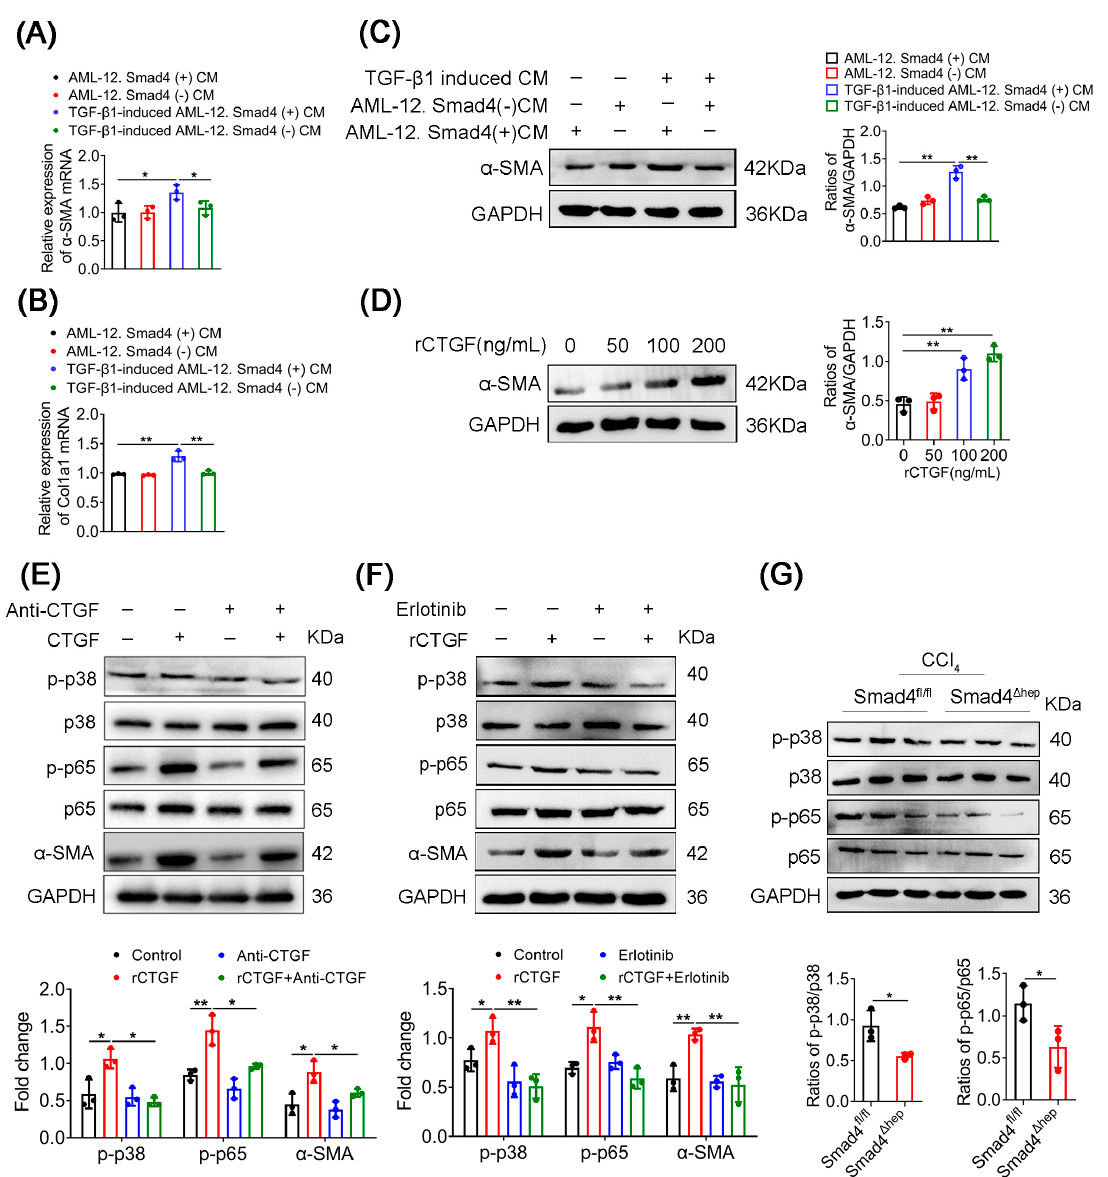
Figure 6. CTGF promotes HSCs activation via the EGFR receptor mediated p38/p65 signaling. AML-12 cells were transfected with control siRNA or Smad4 siRNA, respectively, and treated with TGF- β 1 (5 ng/mL) for 24 h. Subsequently, the conditioned medium was collected to treat LX-2 cells. ( A , B ) The mRNA levels of α -SMA and Col1a1 in LX-2 cells were measured using the real-time PCR method. ( C ) Western blotting analysis of α -SMA protein levels in LX-2 cells. α -SMA was normalized to GAPDH. ( D ) LX-2 cells were treated with recombinant CTGF protein (0 ng/mL, 50 ng/mL, 100 ng/mL, 200 ng/mL) for 48 h. Western blotting analysis of protein levels of α -SMA in LX-2 cells. α -SMA was normalized to GAPDH. ( E ) LX-2 cells were treated with 200 ng/mL recombinant CTGF and 10 ug/mL CTGF-neutralizing antibody (Anti-CTGF) for 48 h. Western blotting analysis of protein levels of p-p38, p38, p-p65, p65, and α -SMA in LX-2 cells. p-p38 and p-p65 were normalized to p38 and p65, respectively, and α -SMA was normalized to GAPDH. ( F ) LX-2 cells were treated with 200 ng/mL recombinant CTGF and 10 nM Erlotinib for 48 h. Western blotting analysis of protein levels of p-p38, p38, p-p65, p65, and α -SMA in LX-2 cells. p-p38 and p-p65 were normalized to p38 and p65, respectively, and α -SMA was normalized to GAPDH. ( G ) Western blotting analysis of protein levels of p-p38, p38, p-p65, and p65 in fibrotic liver tissues. p-p38 and p-p65 were normalized to p38 and p65, respectively. * p < 0.05, ** p <